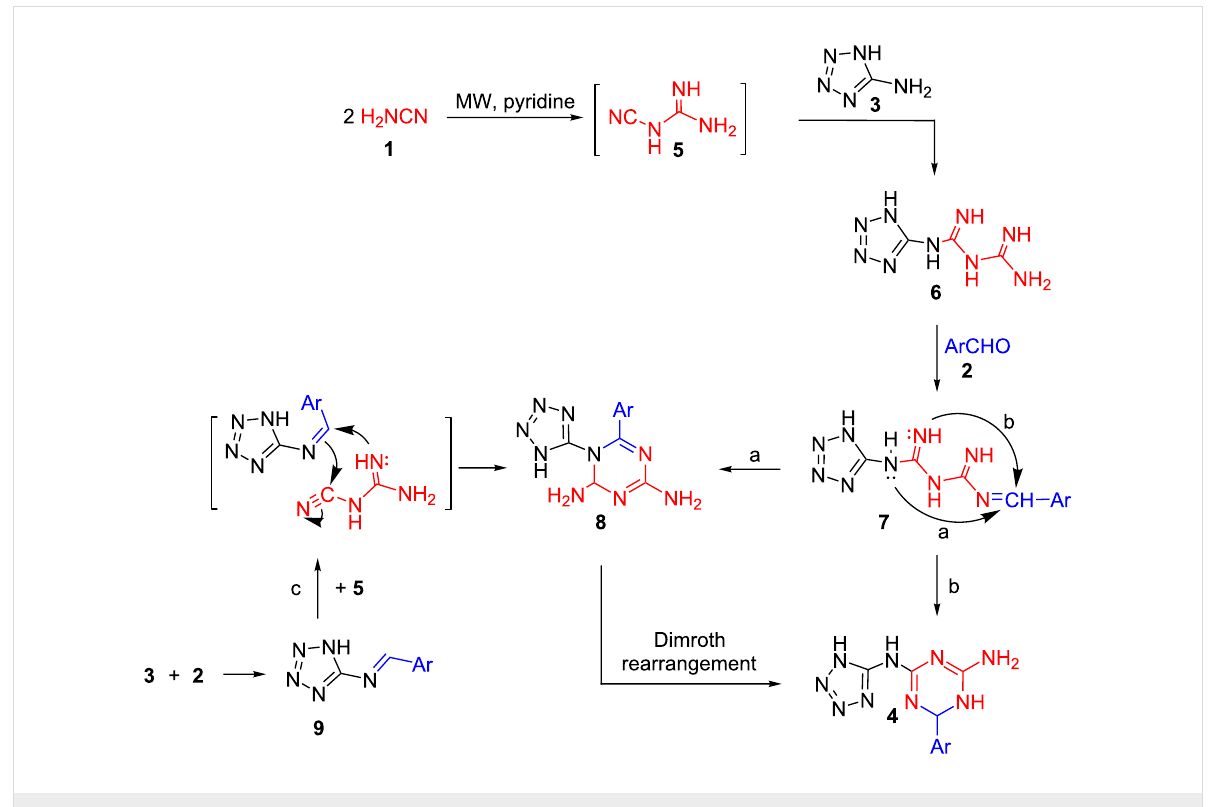
Scheme 3: Plausible different routes to account for the formation of products 4 .